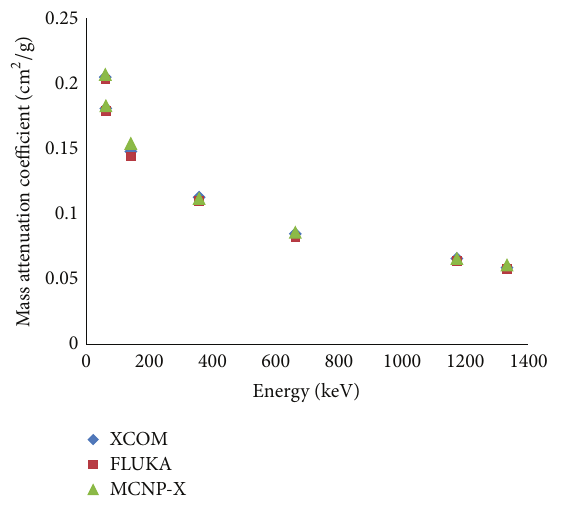
Figure 6: Comparison of mass attenuation coefficients of concrete